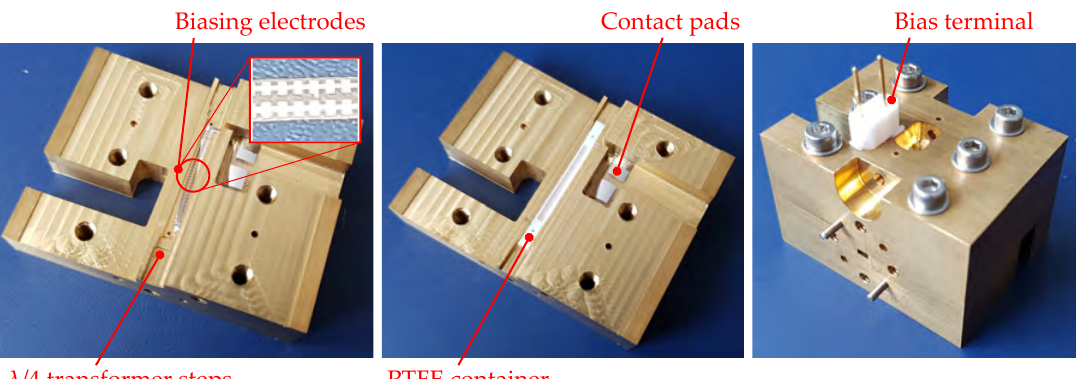
Figure 18. Simulated field distribution of the electrically biased W-band rectangular waveguide phase shifter based on LC.